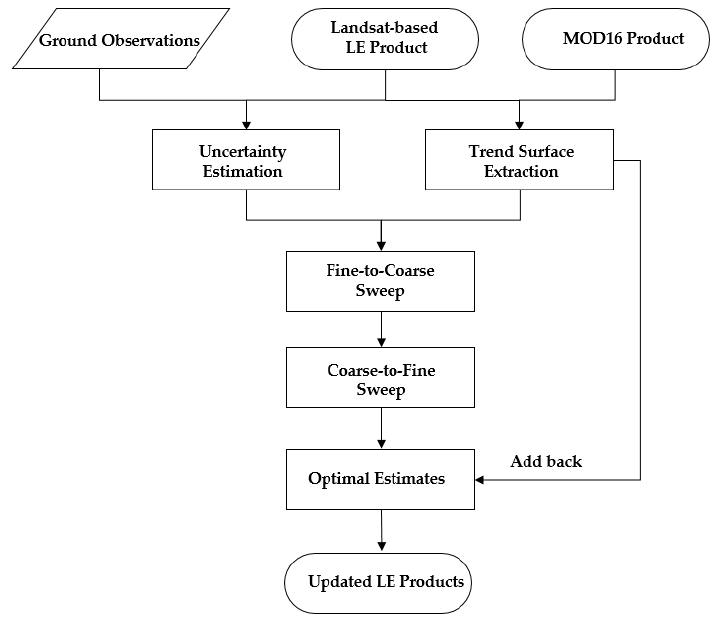
Figure 3. The framework of LE data integration using the MKF method.